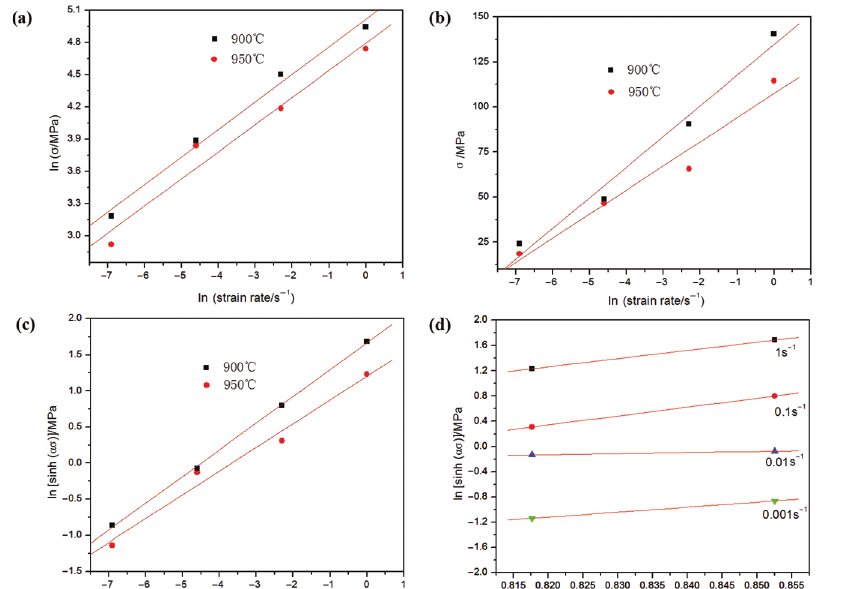
Figure 7: Relationship between (a) ln σ and ln _ ε ; (b) σ and ln _ ε ; (c)